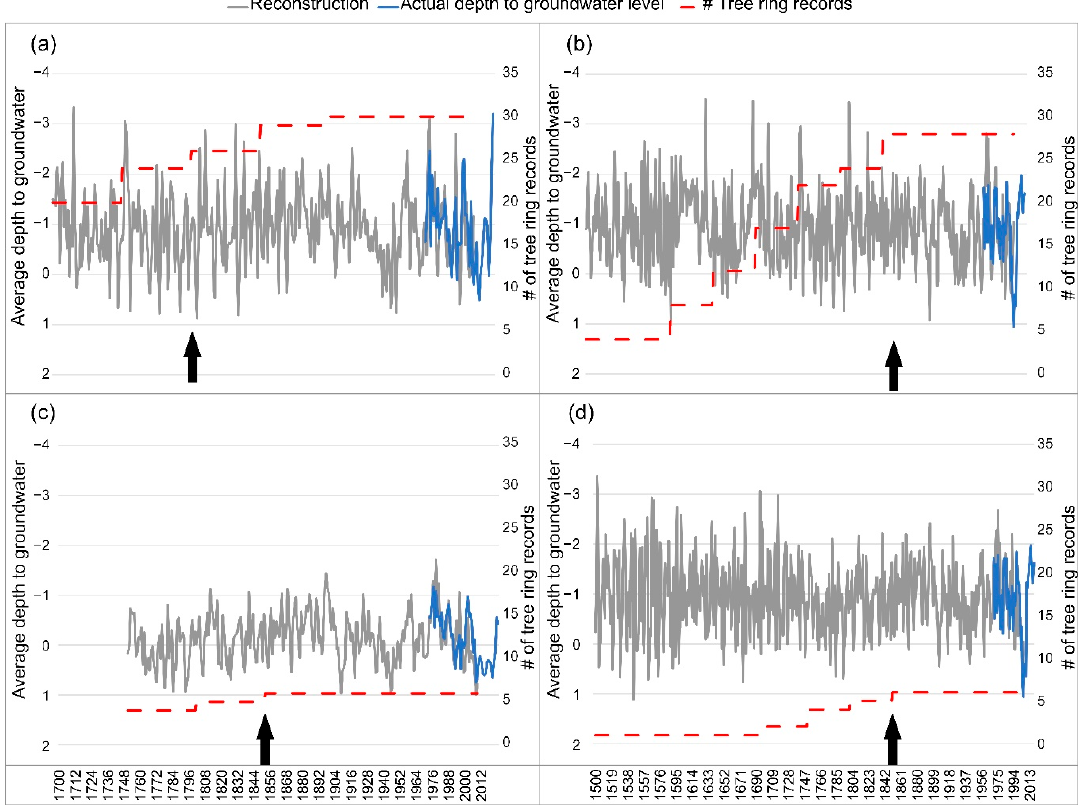
Figure 6. Final groundwater level reconstructions and actual groundwater levels (GWL, shown in dark blue) for the average of wells in the ( a ) streamflow-driven and ( b ) high-elevation recharge-driven models using the climate footprint, and the ( c ) all-wells and ( d ) high-elevation recharge-driven models created using the Coast Mountain Ecoregions. The number of tree ring records used in each model throughout time is shown with the dashed red line. The black arrow indicates the time at which the reconstruction models might be truncated due to increasing uncertainty moving farther back into time (see Section 4).